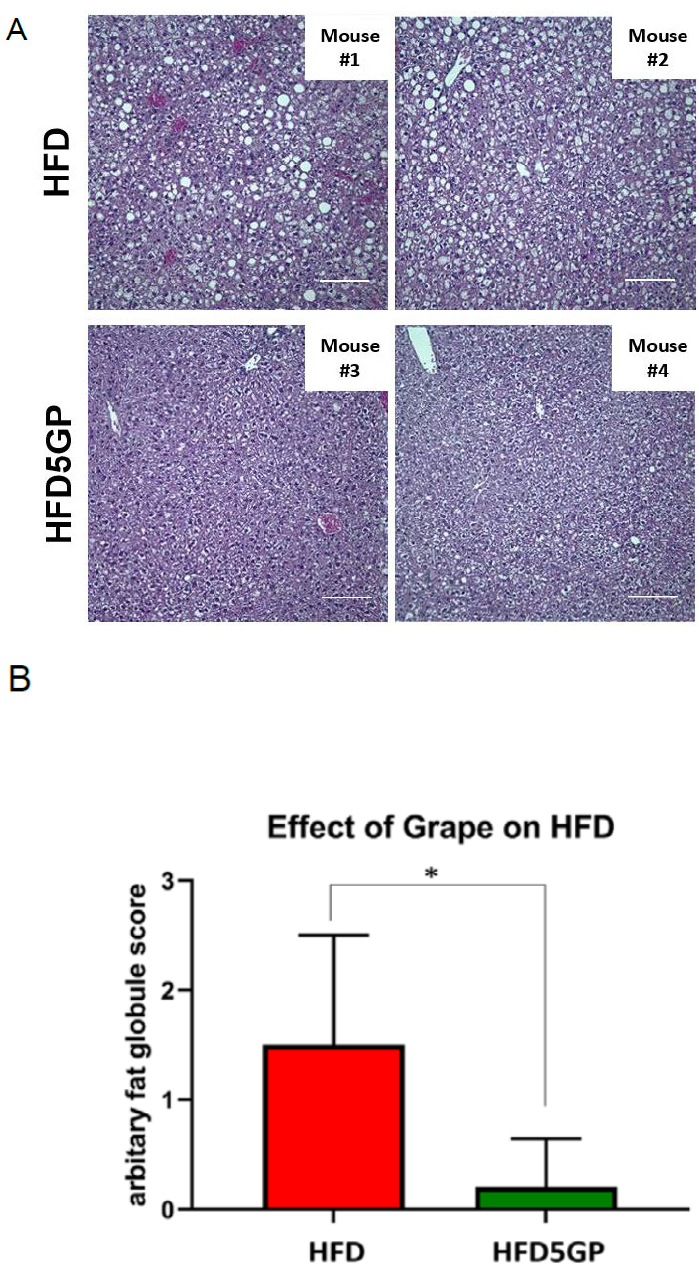
Figure 3. Effect of grape on hepatic steatosis. ( A ) Representative H&E images of liver from mice provided with the HFD (1 and 2) and the HFD5GP (3 and 4) (image magnification, 20X). ( B ) Quan- titation of the number of fat vacuoles in the liver from mice provided with the HFD ( n = 5) or the HFD5GP ( n = 5). Values are presented as mean ± SD. * p = 0.032 and U = 2.0 (Mann-Whitney U test).